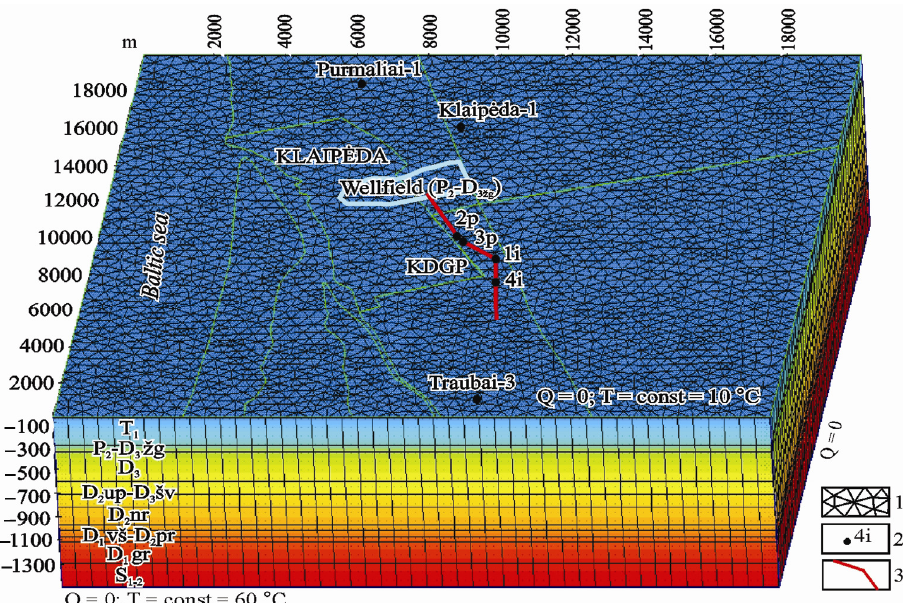
Fig. 3 . Scheme of mathematical model of the upper part of Phanerozoic in the KDGP environs: 1 – model elements in layers; 2 – wells and their names; 3 – direction of the section